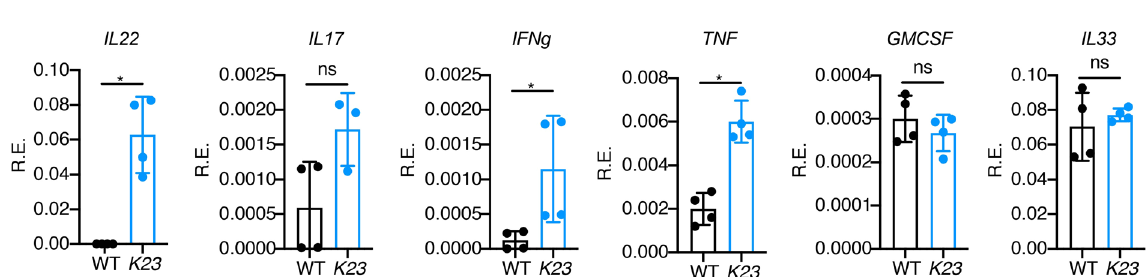
Figure 6. Relative expression of cytokines in the ears of K23 mice after TAM treatment. Relative expression of cytokines (IL-22, IL-17, IFNg, TNF, GMCSF and IL-33) in the ears of WT and K23 mice 8 weeks after TAM treatment (n = 3–4 mice/group). * p < 0.05, ns, not significant by non-parametric Mann-Whitney